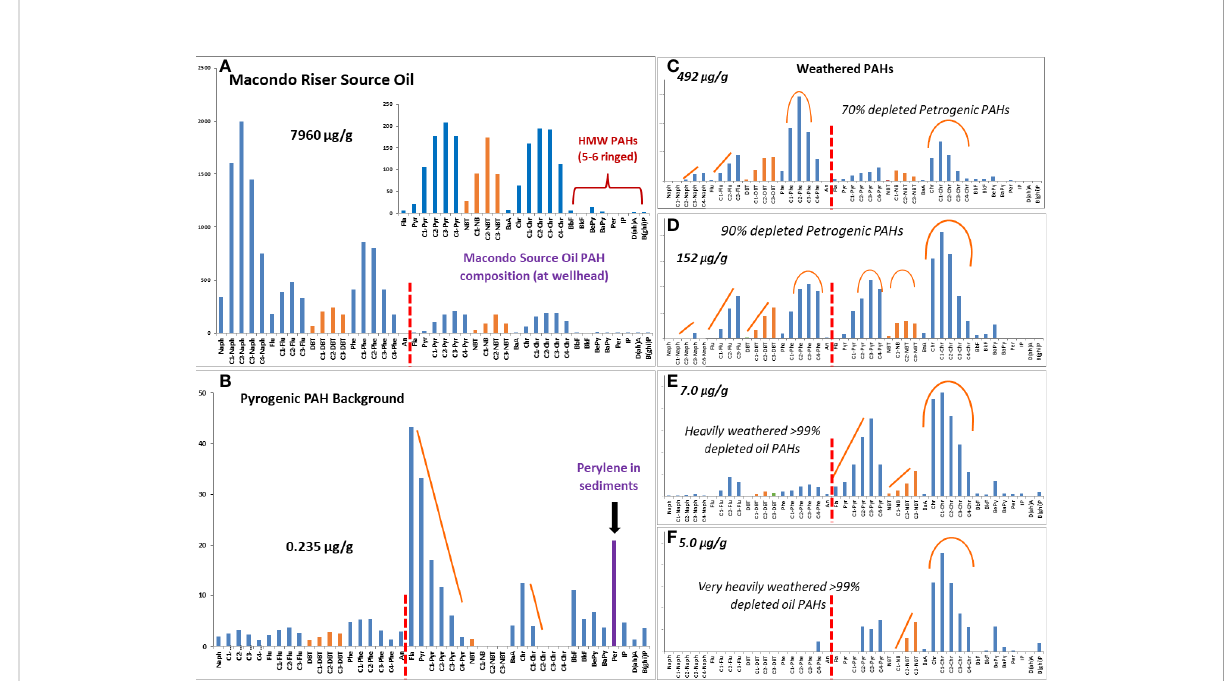
FIGURE 7 Chemical compositions and compositional pro fi les of Petrogenic and Pyrogenic PAH compounds typically found in environmental samples, such as sediments collected from coastal marshes impacted by the 2010 DwH oil spill. (A) shows the PAH quantitative composition and composition pro fi le of the source MC252 liquid Riser oil. The arrows indicate the relative quantities of un-substitutes or parent PAH compounds and the red dashed lines show portions of PAH compounds found with two and three rings and with four rings; (B) shows PAH quantitative composition in a sediment core sample containing no evidence of oil contamination, i.e., no hopane/sterane biomarker compounds and with parent PAH concentrations much higher than its alkyl homologs; (C – F) show PAH quantitative compositions and pro fi les in progressively more weathered oil residues (from top to bottom) extracted from coastal marsh